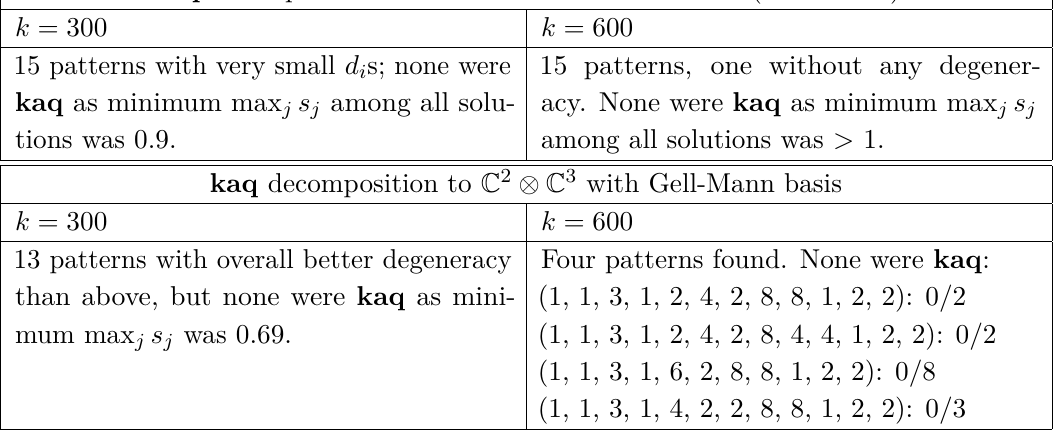
Table 5 . Kaq ness for L 24 on su (6) . We note how it becomes harder to find solutions with